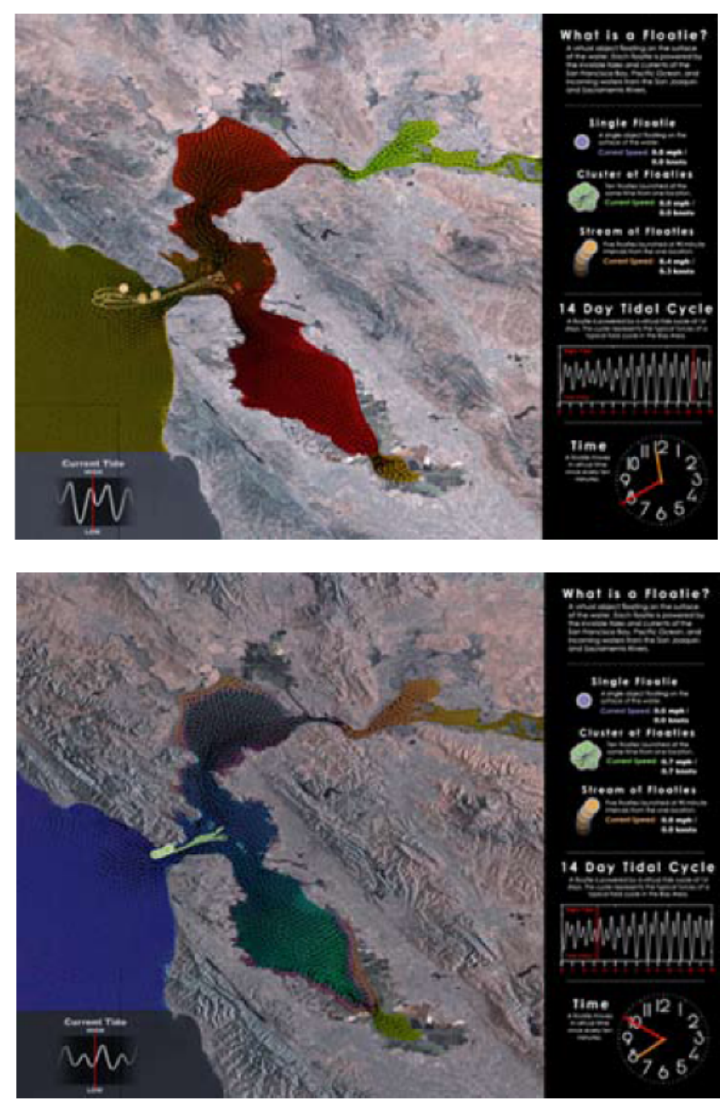
Figure 3. Ma et al. show the interactive software used at the Exploratorium in San Francisco. The purpose of this software is to educate users on the process of how tides, currents and rivers combine in the estuary of San Francisco bay. A touch-screen is used to place floats into the virtual water so that the user can see the effects of the current on the float. Users can watch the effects of predicted tide and river flow cycles on the floats trajectory. Other contextual information is provided as an animation alongside the visualization [67]. Image courtesy of Ma et al.